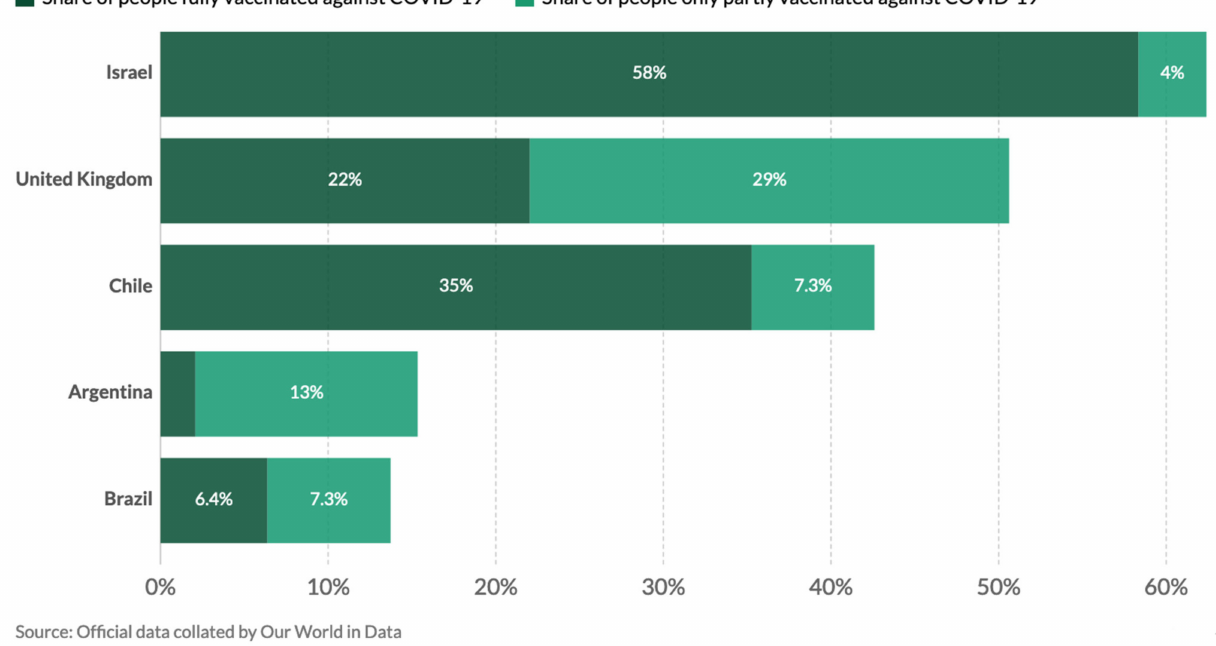
Figure 5. Share of the total population vaccinated against COVID-19, i.e., fully with two doses or partly with one dose, as of 30 April 2021, for Chile. Comparison with other countries in the region (Argentina and Brazil) and the vaccination leaders Israel and UK www.ourworldindata.org (accessed on 1 May